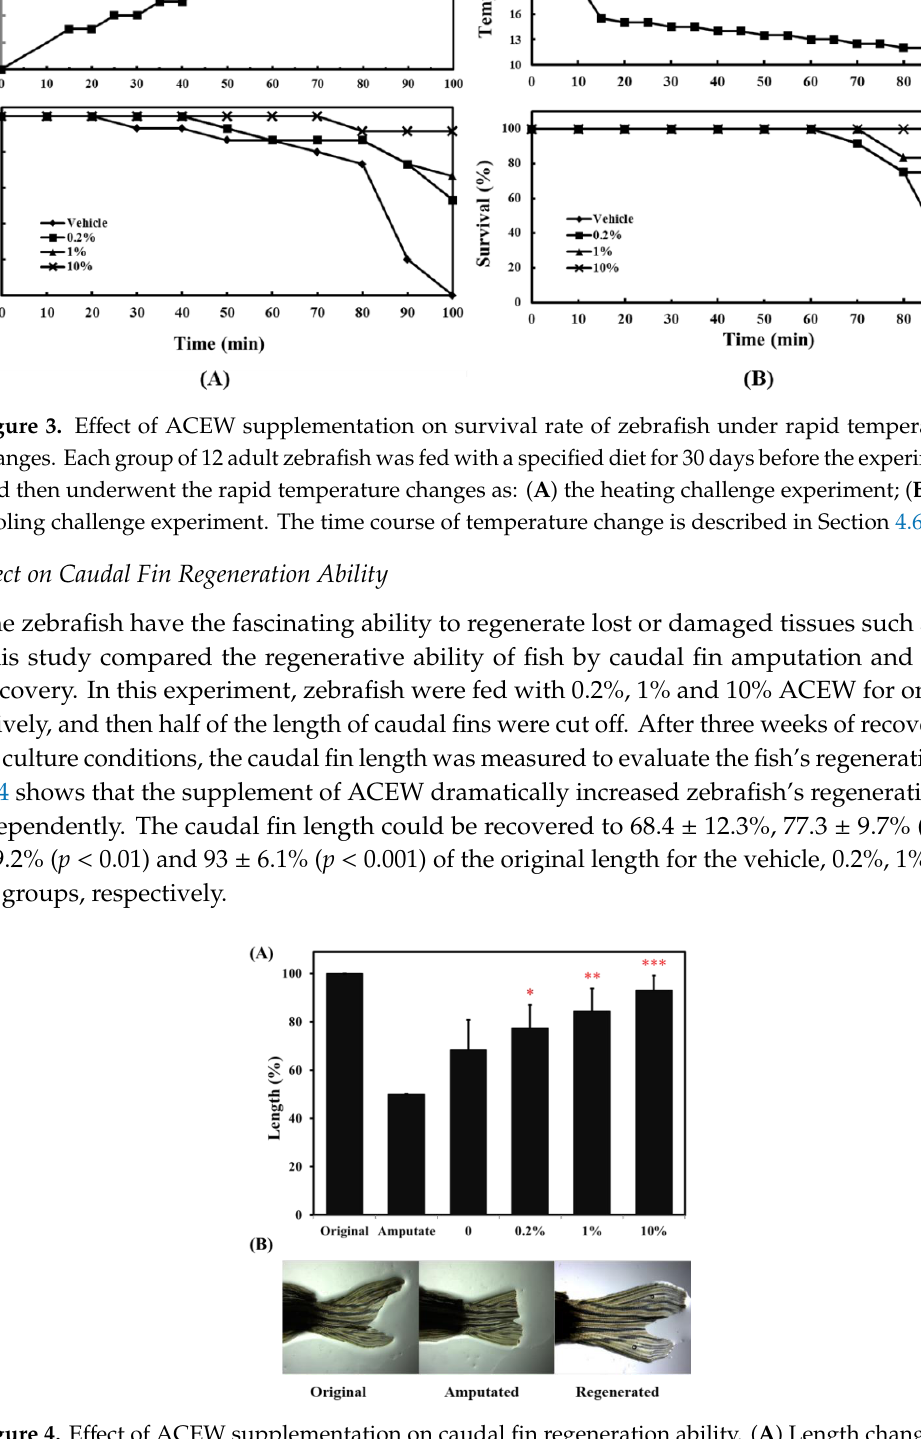
Figure 4. E ff ect of ACEW supplementation on caudal fin regeneration ability. ( A ) Length changes of caudal fins; ( B ) Typical photographs of the original, amputated and regenerated fins. Each group of 20 adult zebrafish was fed with specified diet for 30 days before the experiment, and then half-length of the caudal fin was amputated. After 21-day recovery, the length of caudal fin was measured. Significant di ff erence compared with the vehicle (group 0) was denoted as * p < 0.05, ** p < 0.01, and *** p <